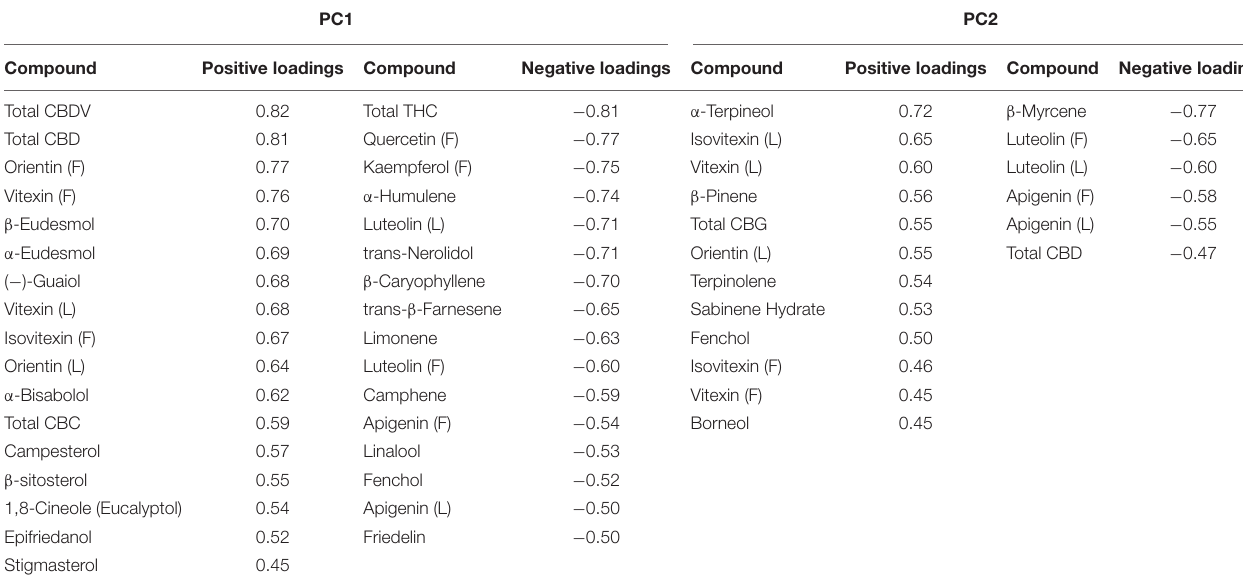
TABLE 2 | Formatted loading matrix for PC1 and PC2 (only compounds with absolute loadings > 0.45 are listed).